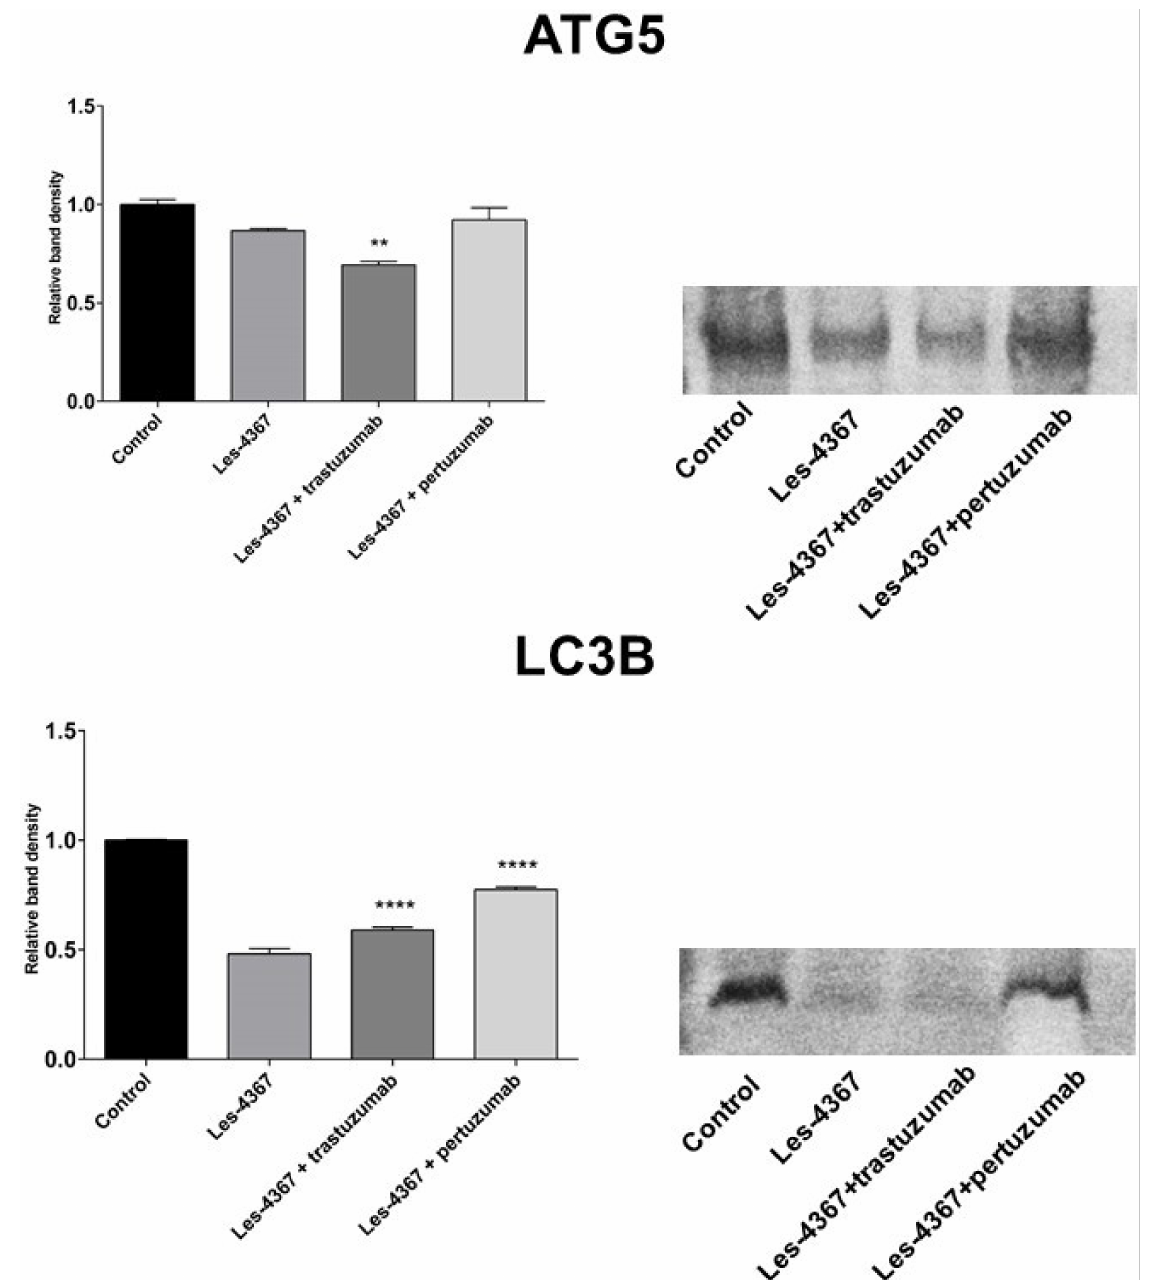
Figure 9. Western blot analyses of ATG5 and LC3B expression in AGS cells after 24 h incubation with Les-4367 (1 µ M), Les-4367+ trastuzumab (1 µ M + 10 µ g/mL), and Les-4367+ pertuzumab (1 µ M + 10 µ g/mL). The results are presented as mean optical density ± SD from three measurements. Statistical significance was calculated using one-way ANOVA with Bonferroni multiple comparison test. Differences were considered statistically significant at ** ( p ≤ 0.005) and **** ( p ≤